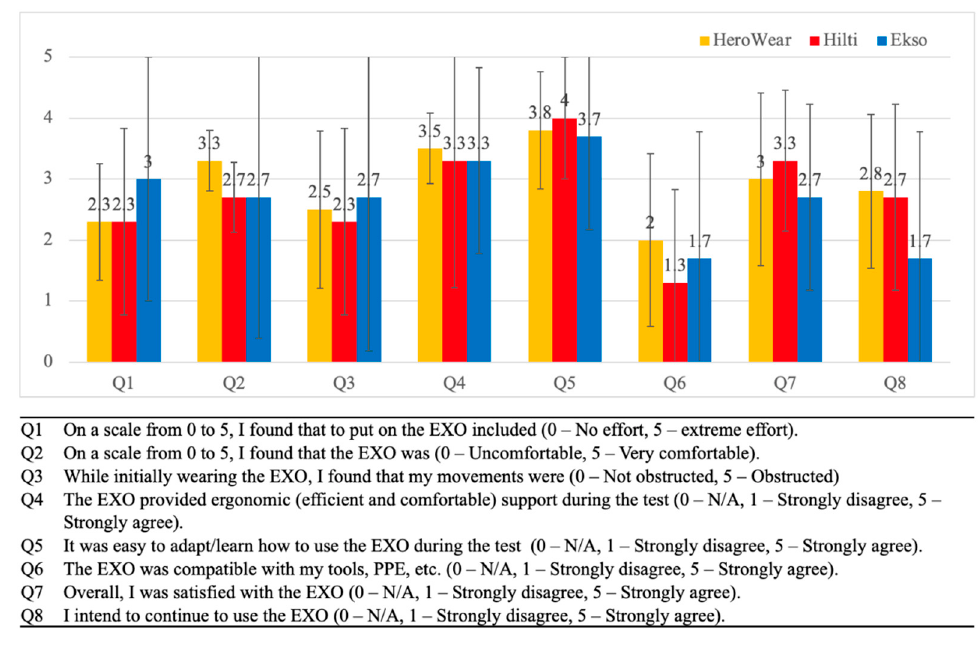
Figure 17. Perceived EXO usefulness, comfortability, and satisfaction.